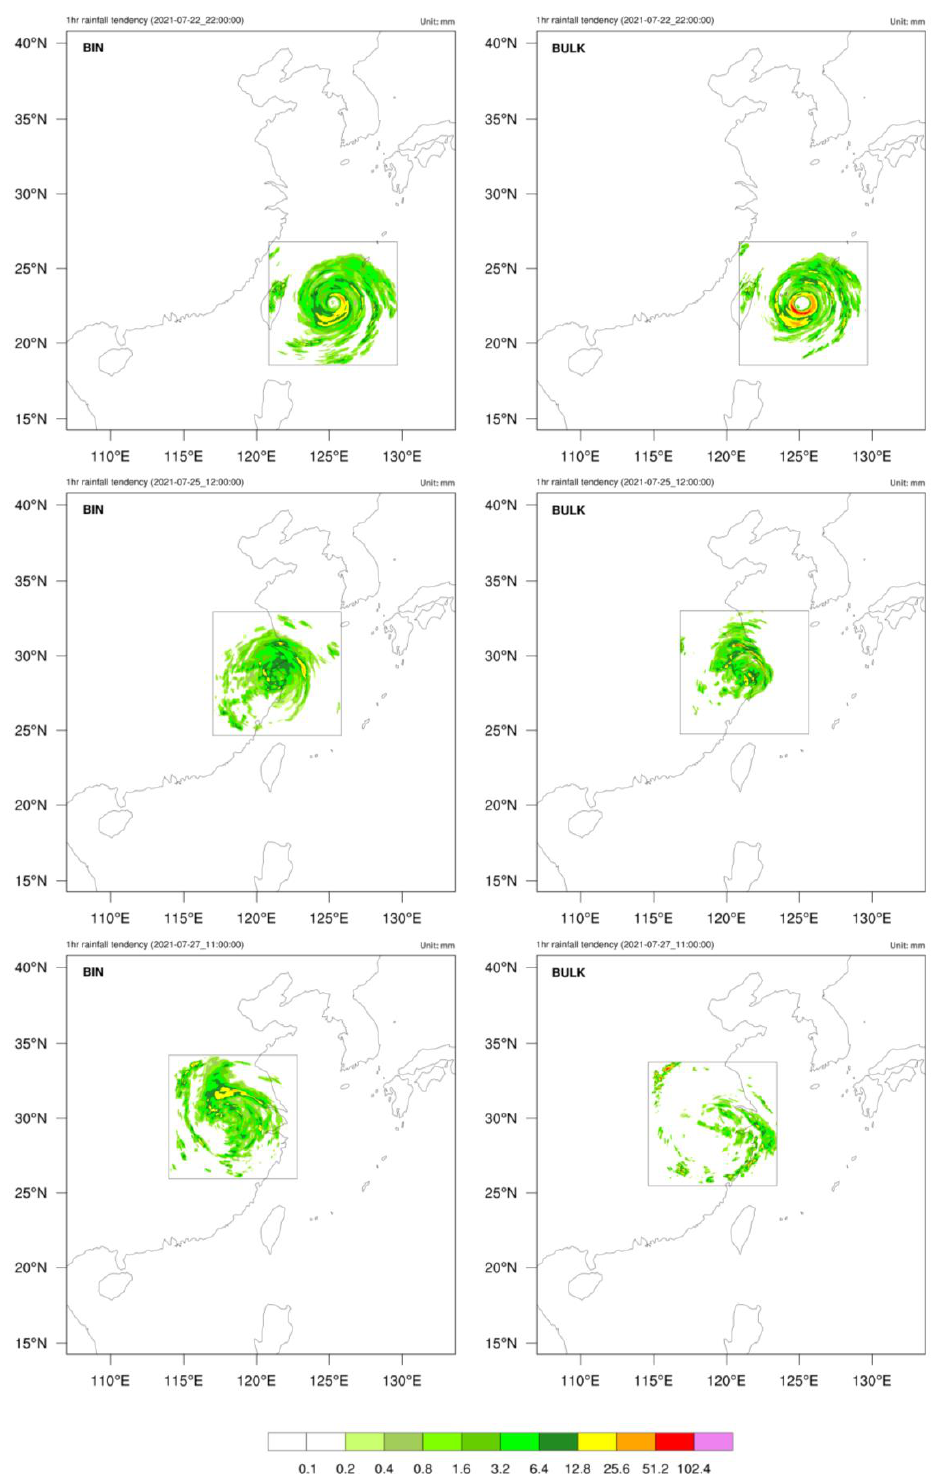
Figure 3. 1-h rainfall tendency (unit: mm) of moving nest domain for the simulated Typhoon In-Fa before, during, and after its landfall.